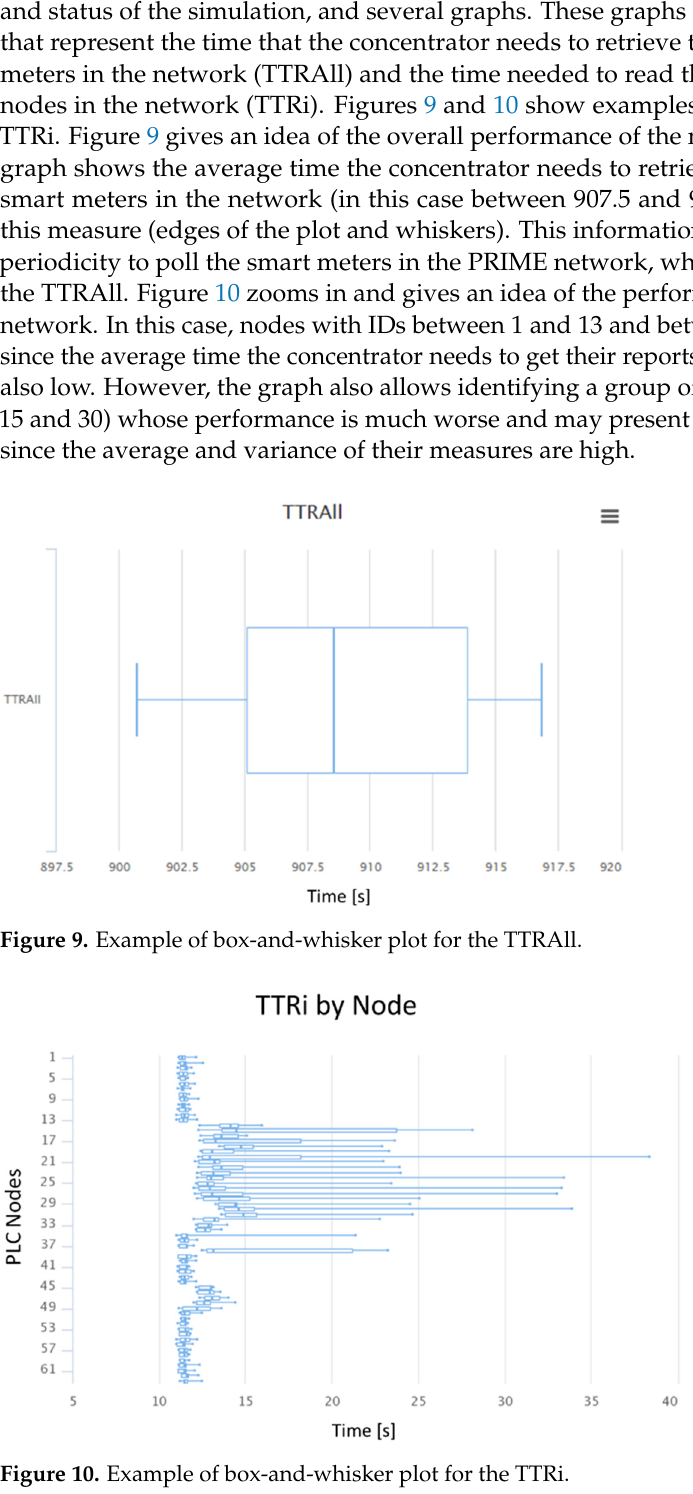
Figure 10. Example of box-and-whisker plot for the TTRi.